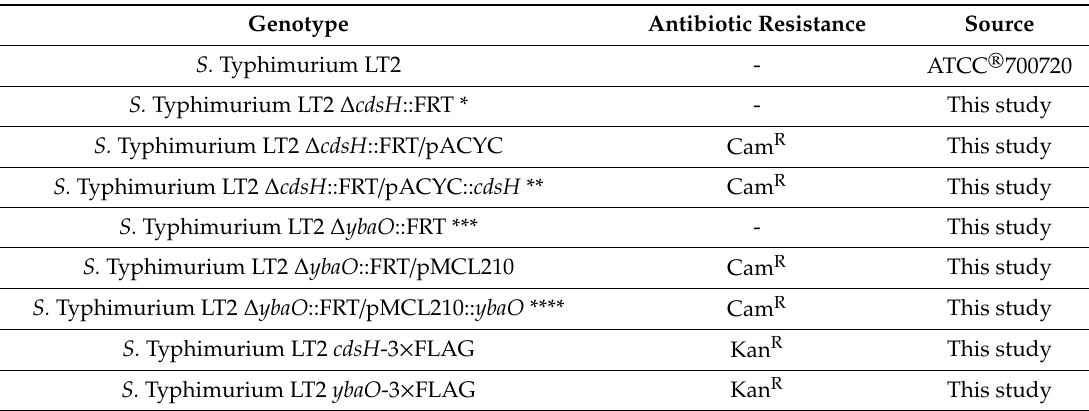
Table 2. Strains used in this